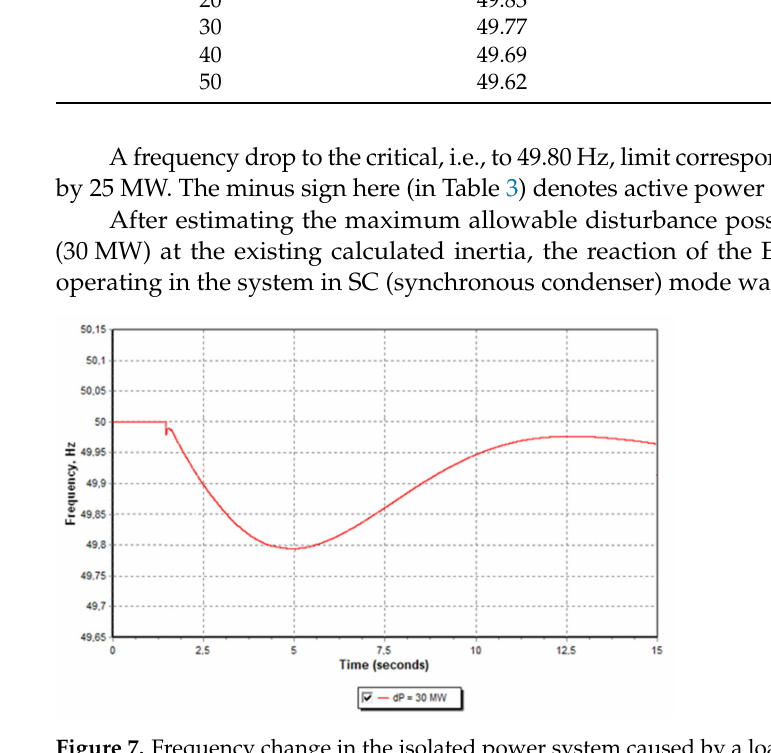
Figure 7. Frequency change in the isolated power system caused by a load increase (case